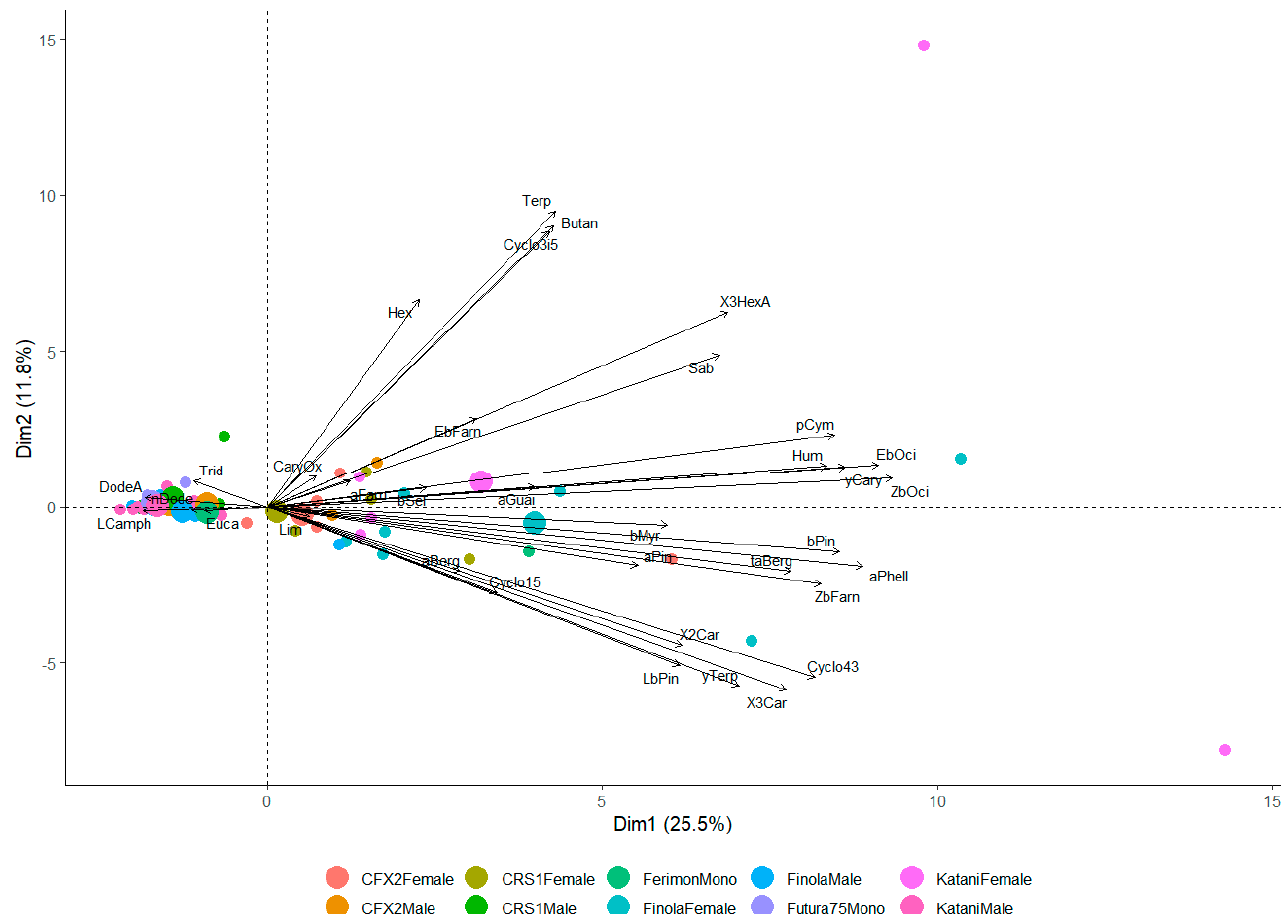
Figure 4. Principal component analysis (PCA) biplot showing scores of individual plants for each cultivar × sex interaction. The PCA was based on the 35 compounds tentatively identified from six hemp cultivars; small circles correspond to individual samples and larger circles correspond to the treatment average.